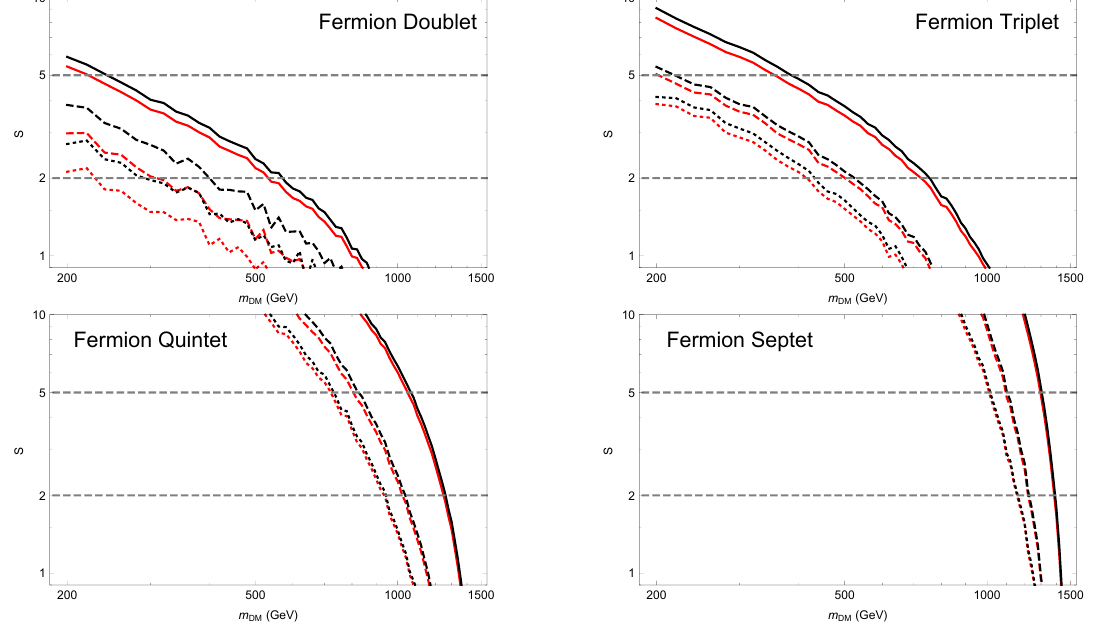
Figure 9 . Signi(cid:12)cances for fermionic EMDM for 2 ab (cid:0) 1 of CLIC data in the mono-photon channel. Top row: complex doublet (left) and real triplet (right). Bottom row: real quintet (left) and real septet (right). The black lines are for limits using parton-level observables; the red for those with the detector simulation as described in the text. Solid (dashed, dotted) lines are for 0% (0.5%, 1%) systematic uncertainties. The grey dashed horizontal lines show the 5 (cid:27) -discovery and 95%-exclusion points.